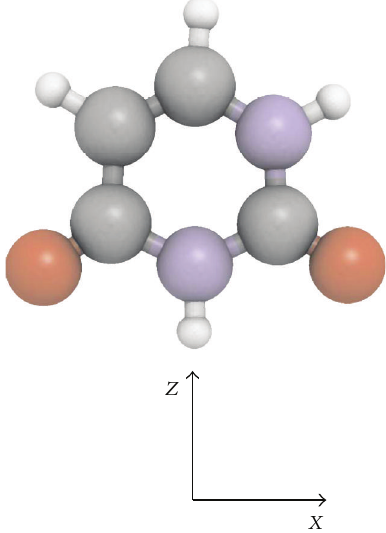
Figure 1: Structure of uracil and Cartesian coordinate system. Colours: white (hydrogen), grey (carbon), red (oxygen), and cyan (nitrogen) (colour figure online).